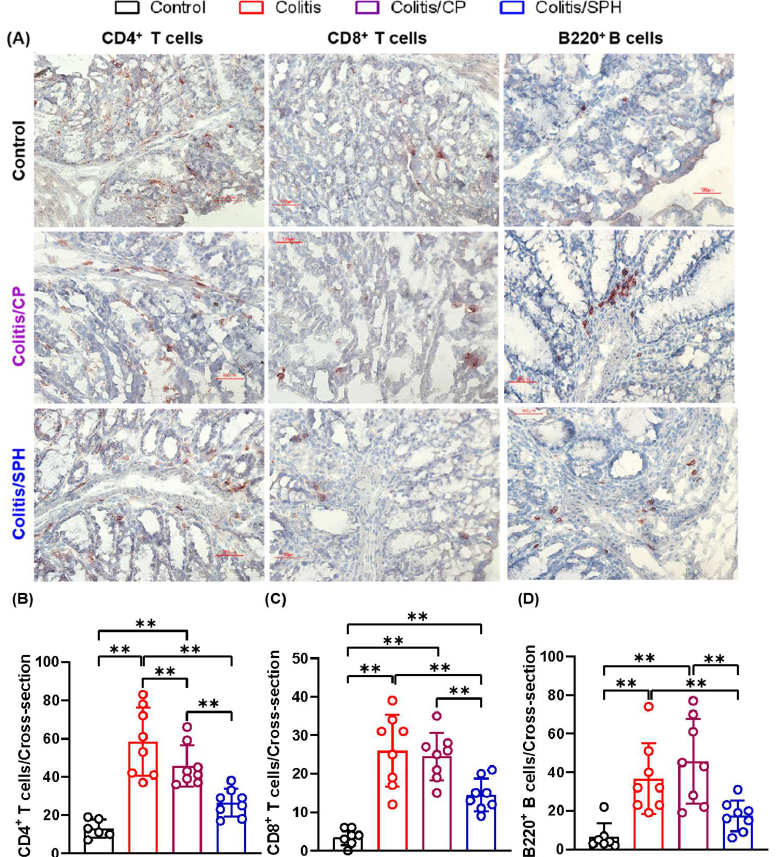
Figure 4. SPH reduces the infiltration of lymphocytes in TNBS-induced colitis model. ( A ) IHC images ( × 200) and ( B – D ) the numbers of CD4-, CD8- and B220-positive stained cells per colonic cross-section area. The infiltration of CD4 + T, CD8 + T and B220 + B lymphocytes in colon tissue were significantly increased in the Colitis (n = 8) and Colitis/CP (n = 8) groups compared with the Control group (n = 7), while SPH treatment (n = 8) significantly reduced the infiltration of lymphocytes in the colon tissues. Data are presented as mean ± SD and analyzed by one-way ANOVA test. **: p < 0.01.